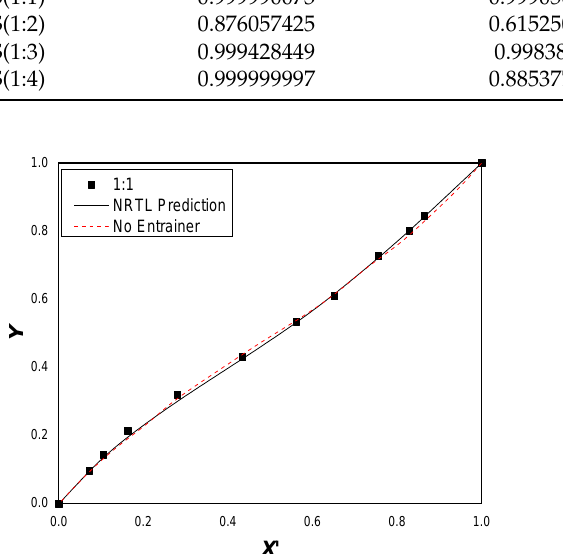
Table 7. Coefficient of determination (R 2 ) of the pseudo-ternary systems fitted using the three thermodynamic models. R 2 System NRTL WILSON UNIOUAC